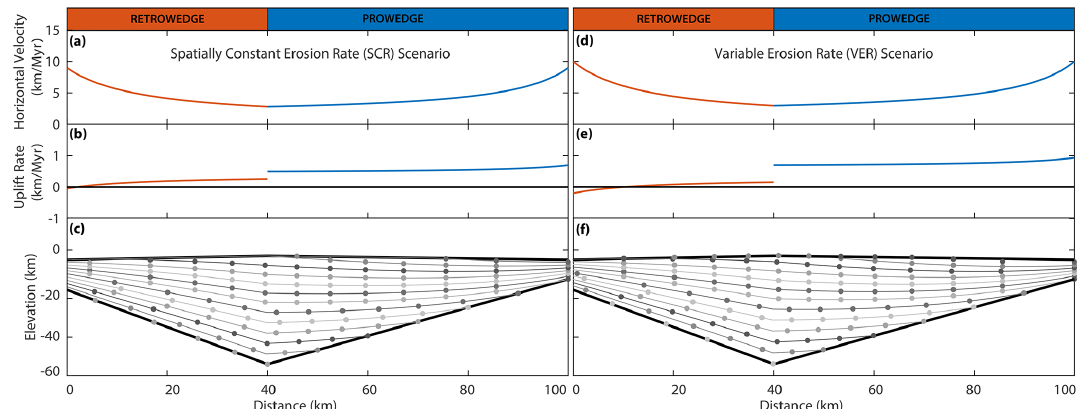
Figure 10. Kinematic model results for the spatially constant erosion rate (SCR) scenario (a–c) and the variable erosion rate (VER) sce- nario (d–f) . (a, d) Predicted material horizontal velocities across the orogenic wedge and (b, e) predicted uplift rates across the wedge. (c, f) Material motion paths (lines within wedge) and particle positions and paths, equally spaced in time (solid, coloured